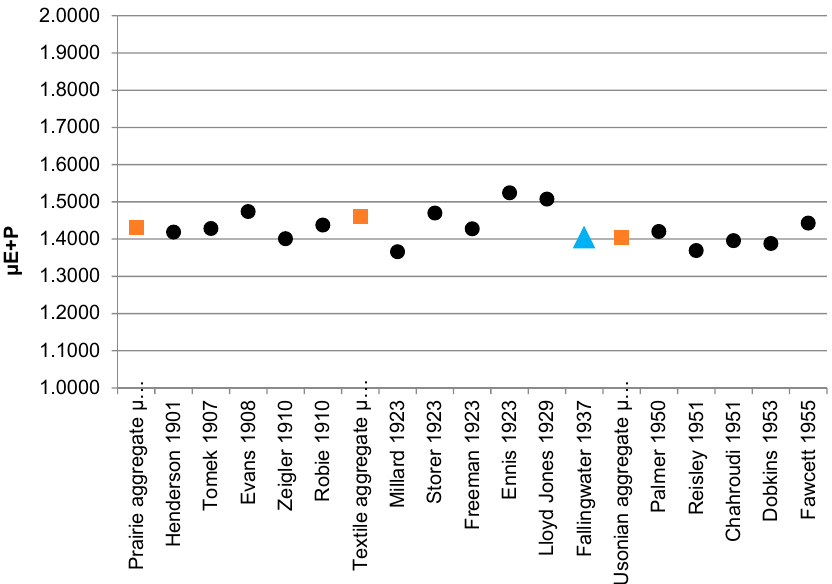
Figure 11. Composite results (elevations and plans): mean [ • ]and aggregate [ (cid:4) ] D compared with Fallingwater [ (cid:78) ].